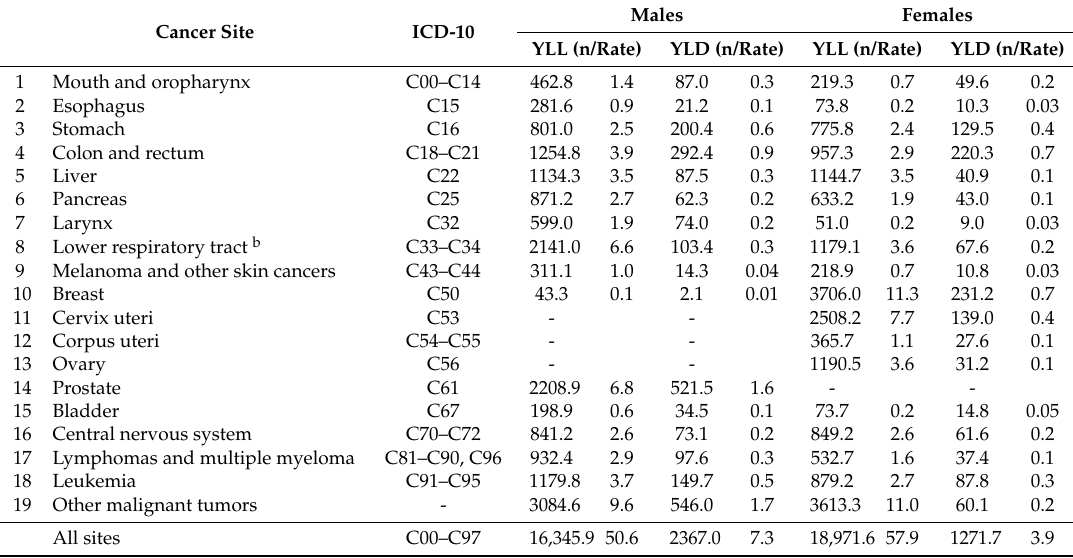
Table 2. Years of life lost, years lived with disability, and unadjusted rates per 1000 inhabitants, Colima, Mexico